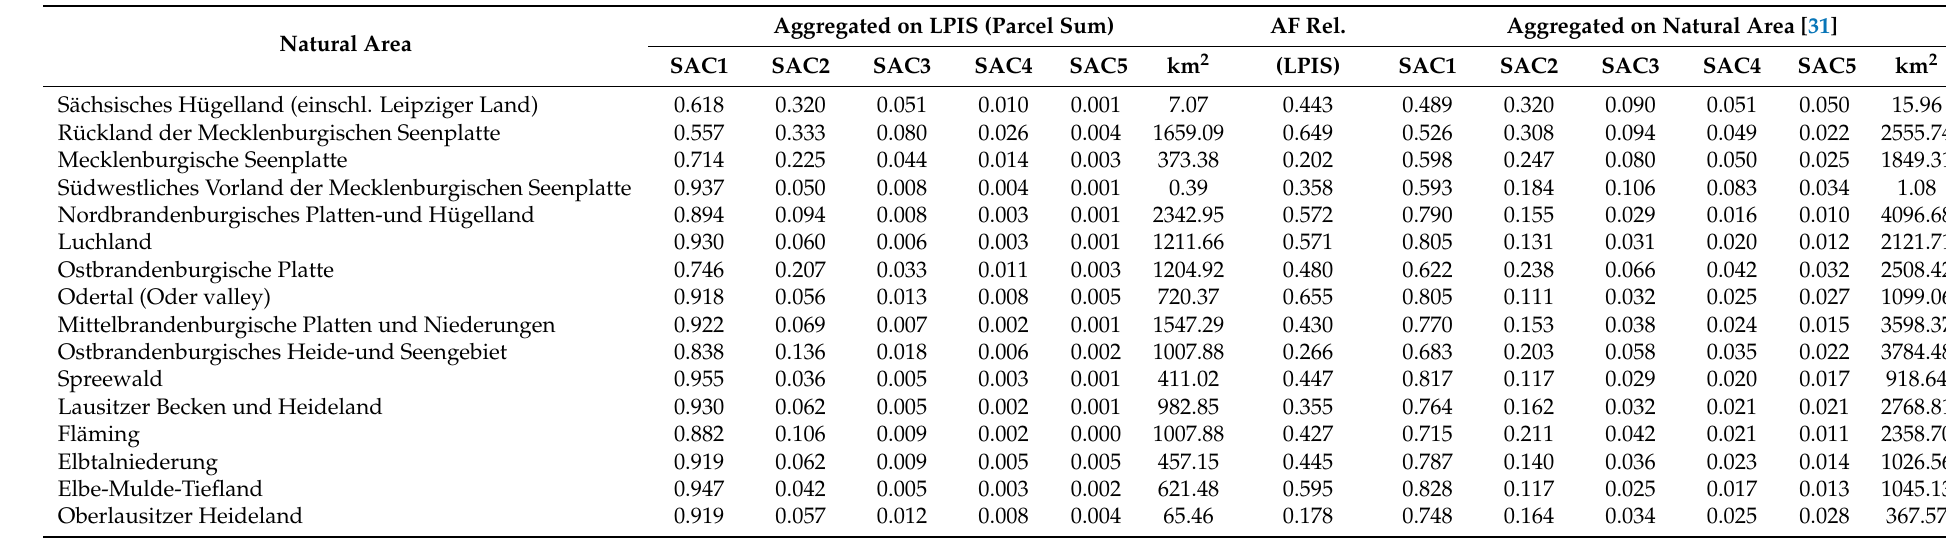
Table 4. Area portion of SAC in LPIS and natural areas; AF-agricultural used area: area portion relative to the natural area [31,35]. Natural